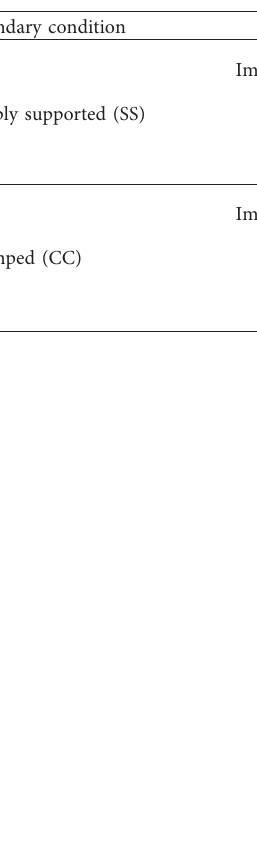
Figure 3: Comparison of bending stiffness predictions ( K 1 ), as obtained from the current SDOF model and literature